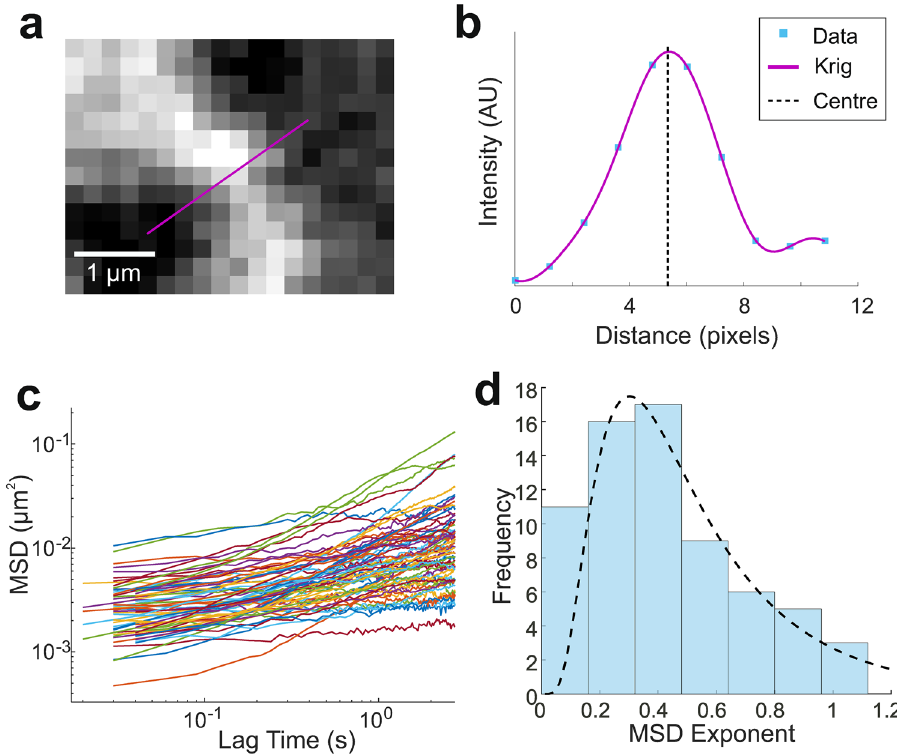
Figure 2. Mean squared displacement of ER tubule oscillations in live Vero cells. ( a ) Fluorescence image of a single ER tubule. The tubule position along the purple line was tracked. ( b ) Fluorescent intensity along the line in ( a ), with krig interpolation and the centre of the fit depicted. ( c ) MSDs of measured transverse tubule fluctuations as a function of lag time. Traces begin at different time points due to slight differences in video frame rates. ( d ) Exponents of the power law fit to the MSDs in ( c ). Dotted line shows lognormal fit with mean exponent 0.54 ±